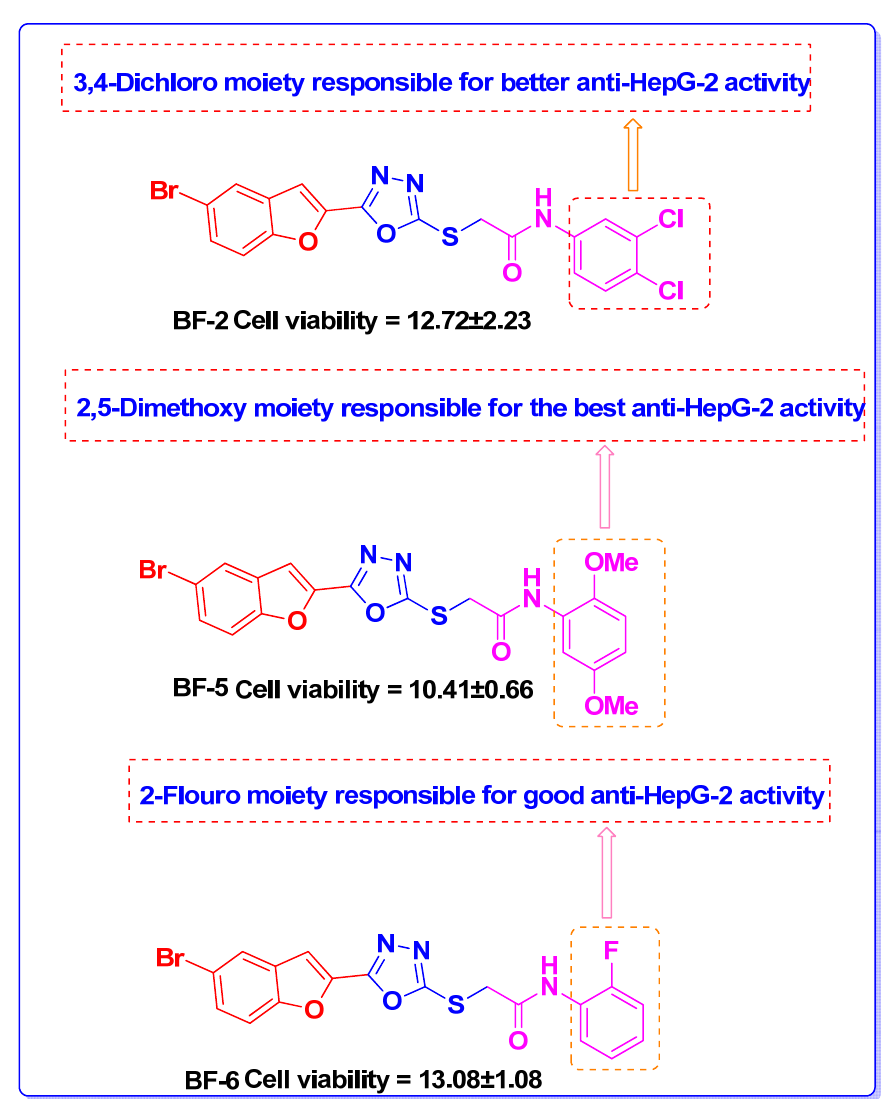
Figure 4. The most bio-active anti-HepG-2